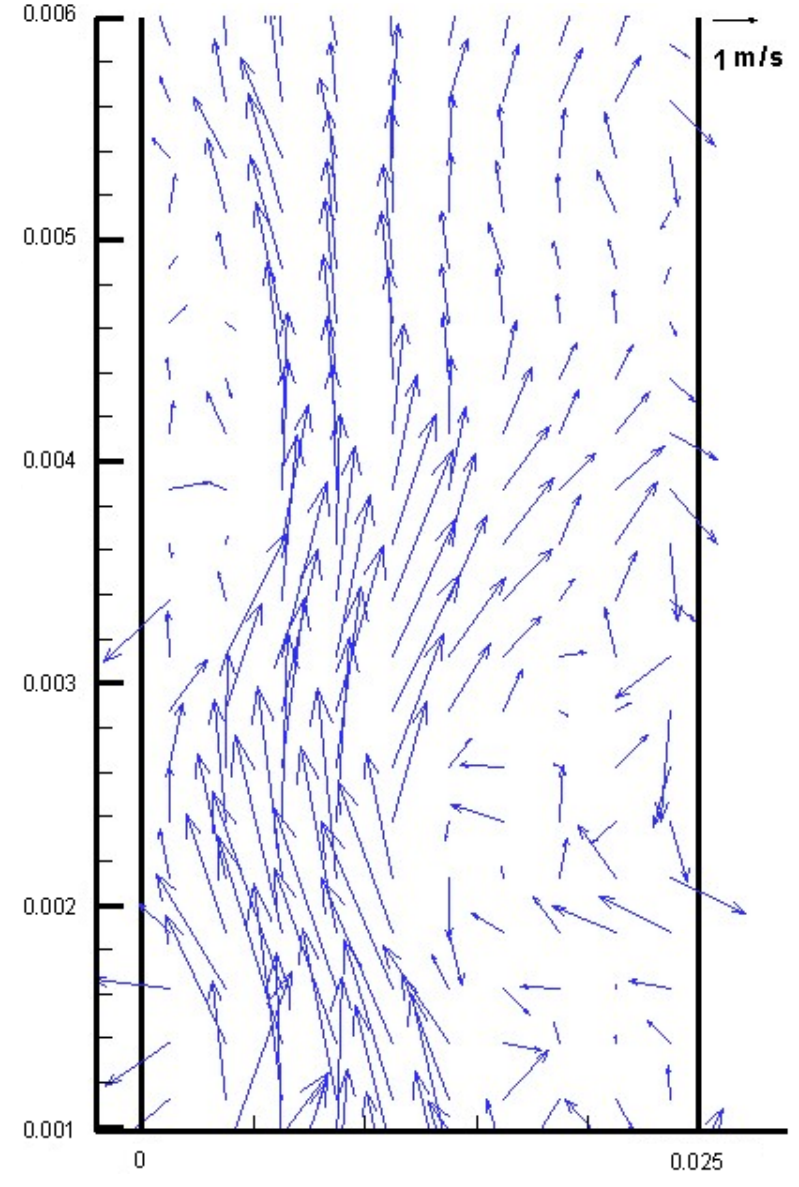
Figure 9. Gas velocity with moderate t r =